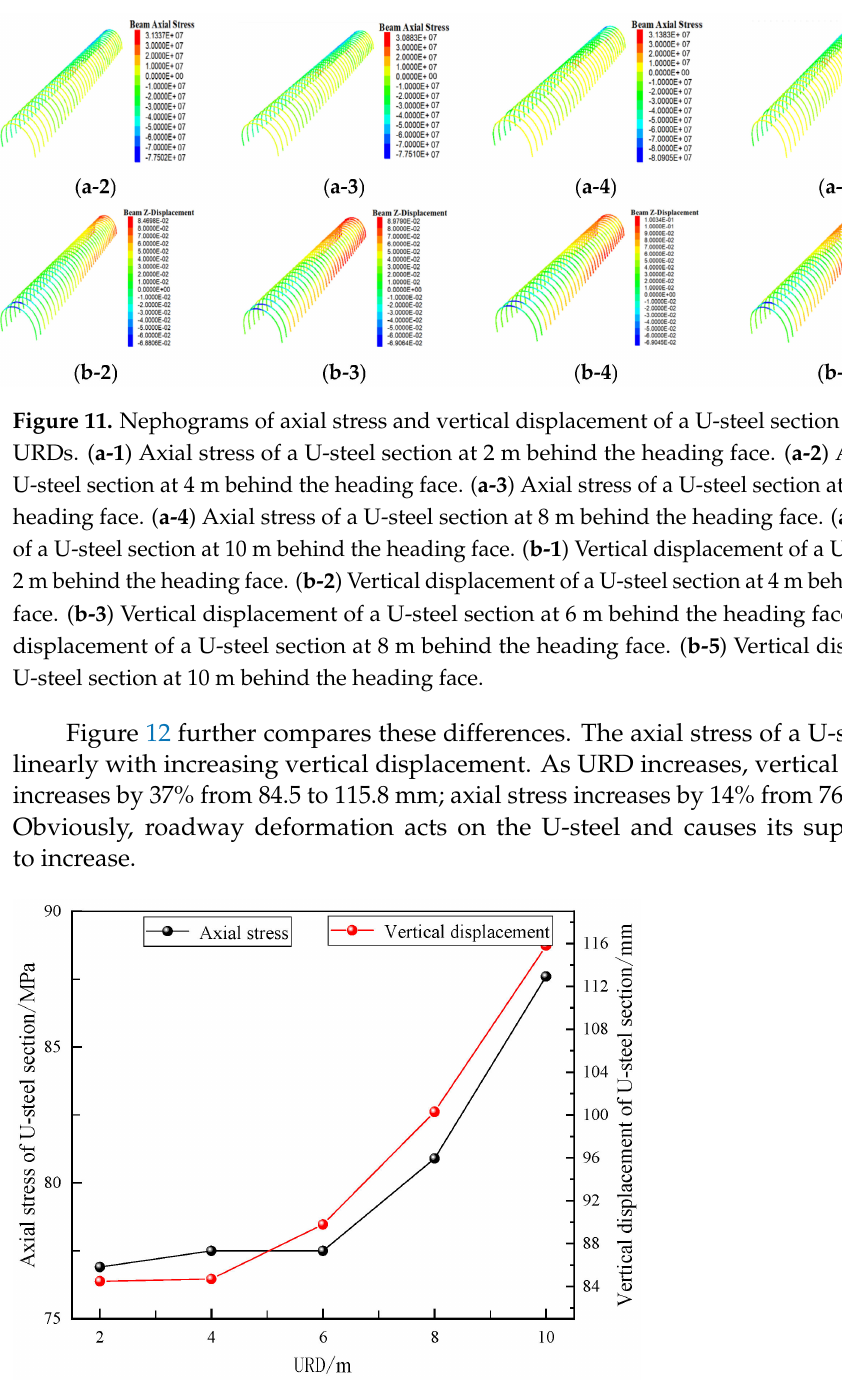
Figure 12. Comparison of axial stress and the vertical displacement of a U-steel section under different